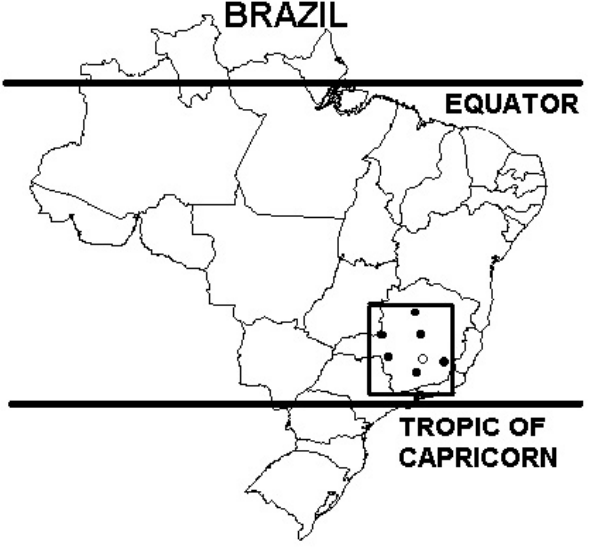
Fig. 1. Map of Brazil indicating the location of the lightning sensors used in this study and of the city of Belo Horizonte.